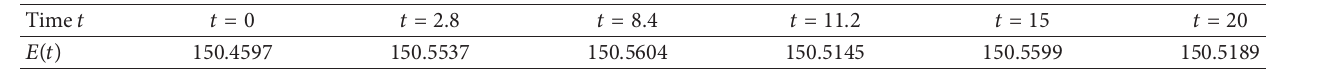
Figure 4: The numerical solutions at times 𝑡 = 9, 15 , with 𝜌 = 1.5 for superposition of two line solitons. Table 3: The energy of the circular ring